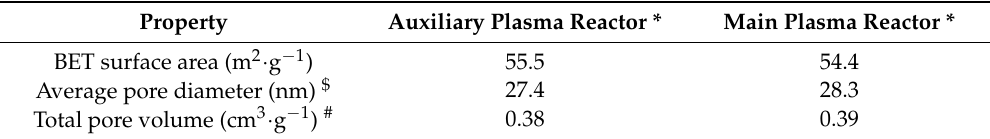
Table 2. Catalyst porosity analysis results by the BET